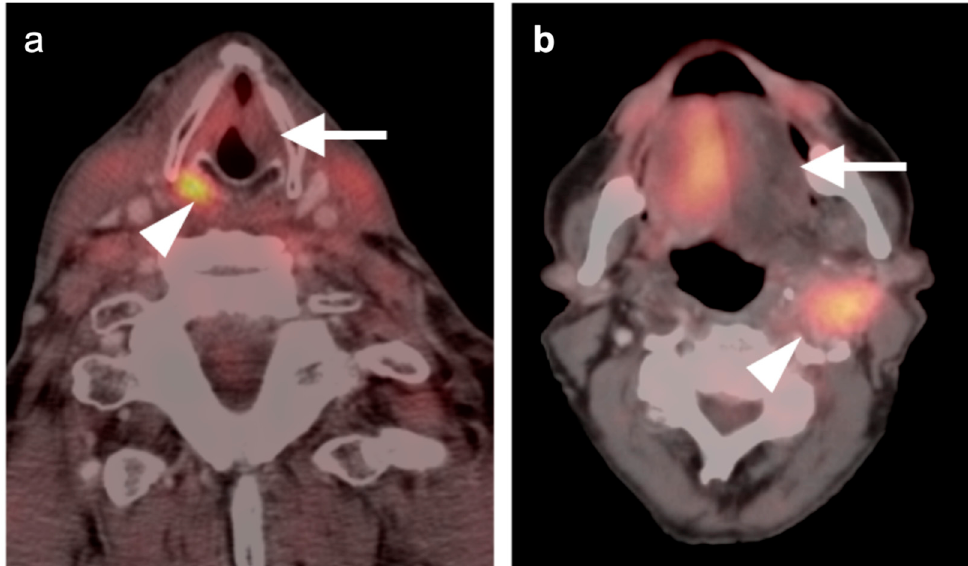
Figure 6. Muscle paralysis with contralateral increased metabolic activity in two patients. ( a ) Paralysis of the left vocal cord, which is patulous and low in metabolic activity (white arrow). There is compensatory contralateral increased activity in the right vocal cord and cricoarytenoid muscle (white arrowhead); ( b ) shown is a paralysis of the left hypoglossal nerve (CN 12) with low attenuation and hypometabolism of the left tongue musculature (white arrow), as well as compensatory increased activity in the right side of the tongue. Note area of recurrent tumor in the left neck (white arrowhead) along the expected course of CN 12.